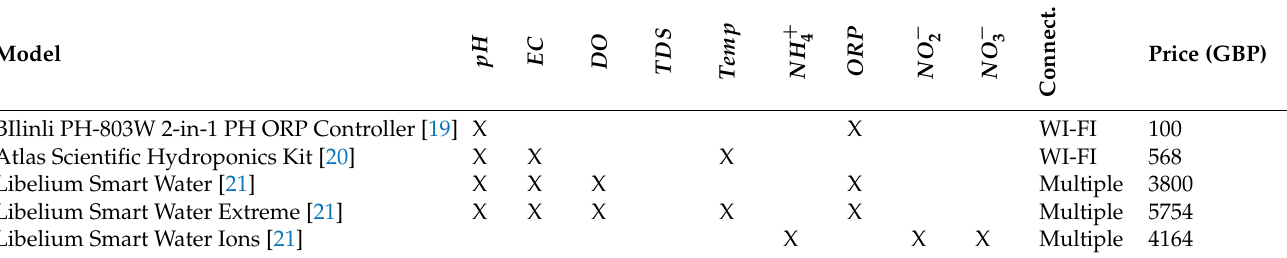
Table 2. Existing Wireless Sensor